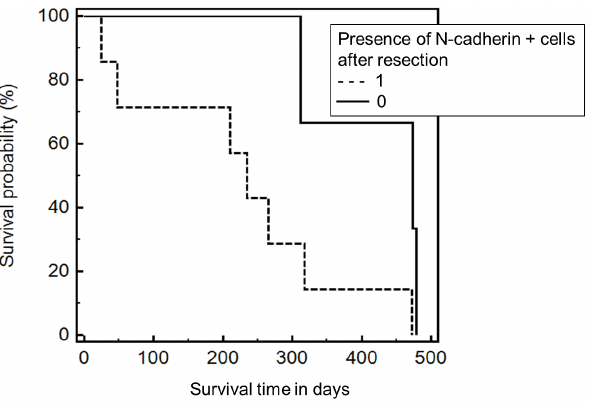
Figure 4. Kaplan Meier test showed a significantly shortened survival when N-cadherin + cells were present after resection (p 5 0.04; 474 vs 235 days; CI: 0.8856–10.8339; [HR] 5